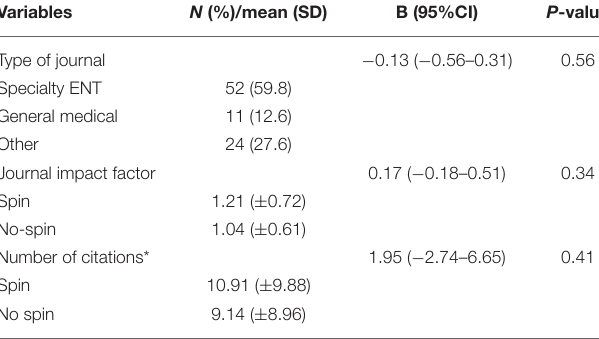
TABLE 3 | Effects of actual